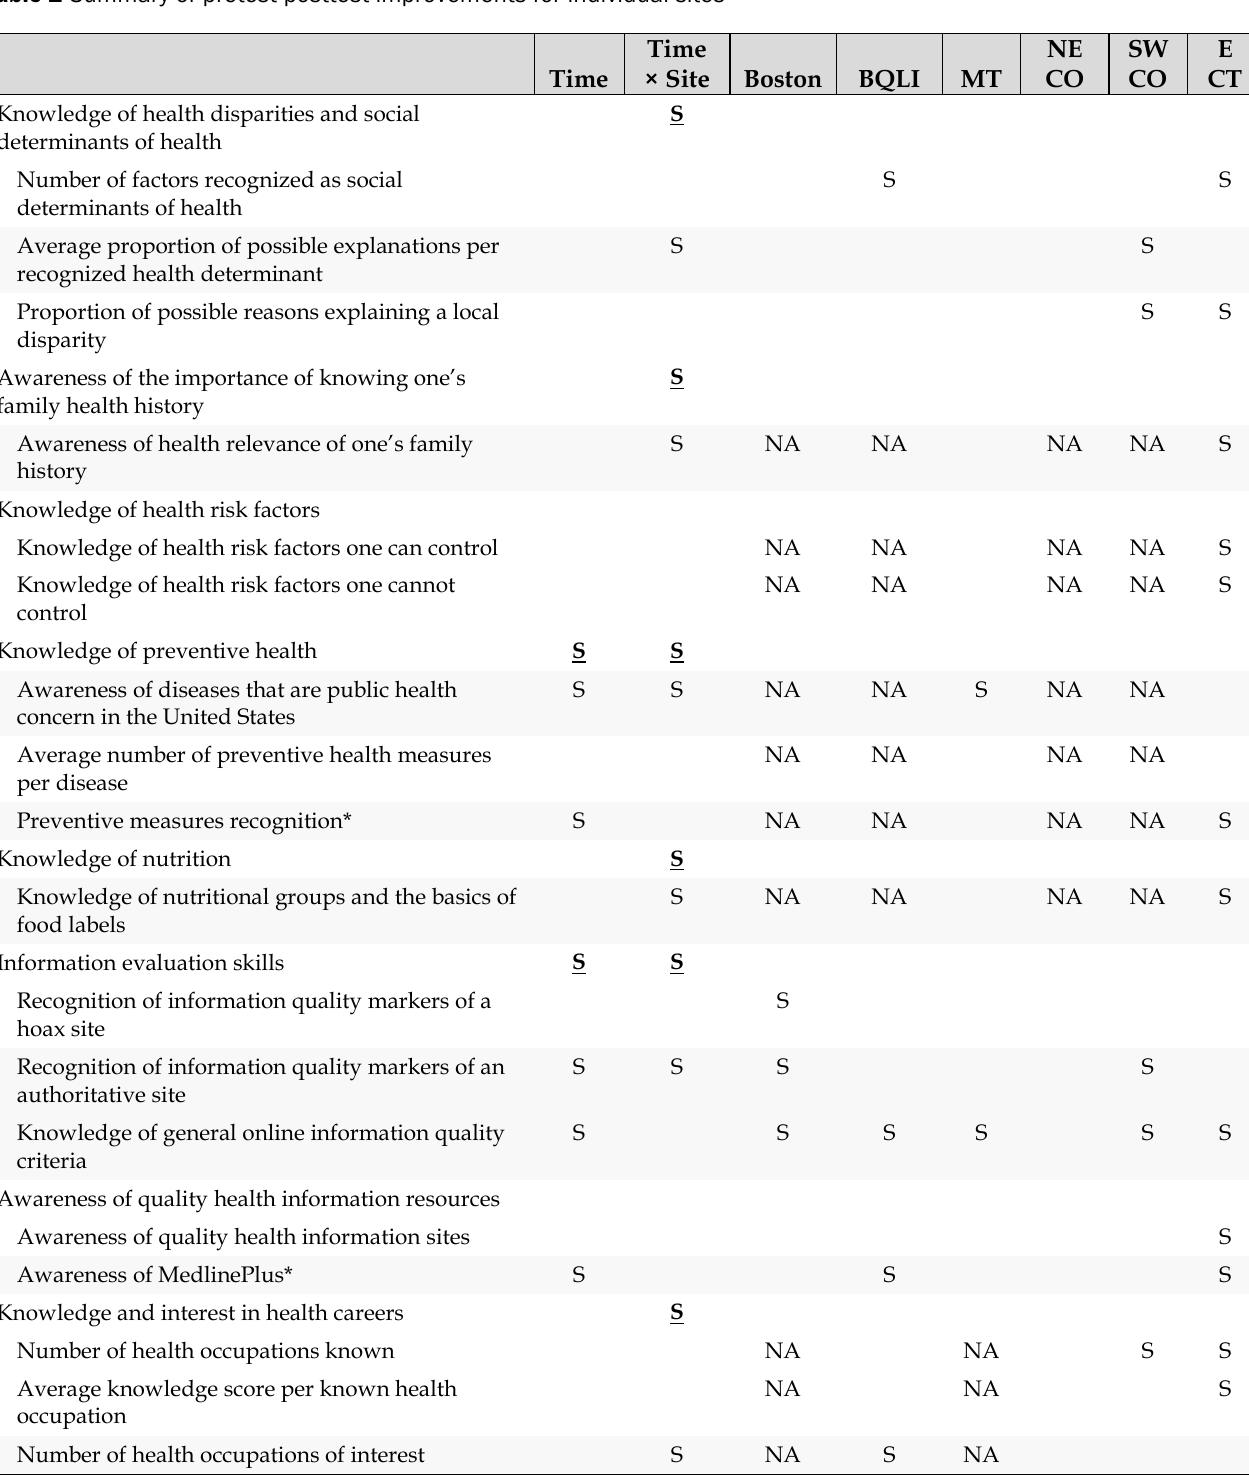
Table 2 Summary of pretest-posttest improvements for individual